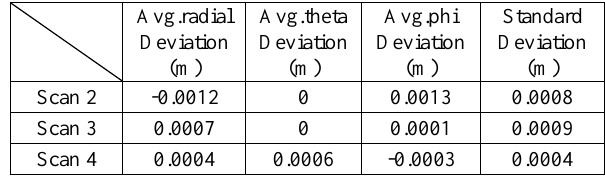
Table 7. Registration accuracy between the adjacent stations